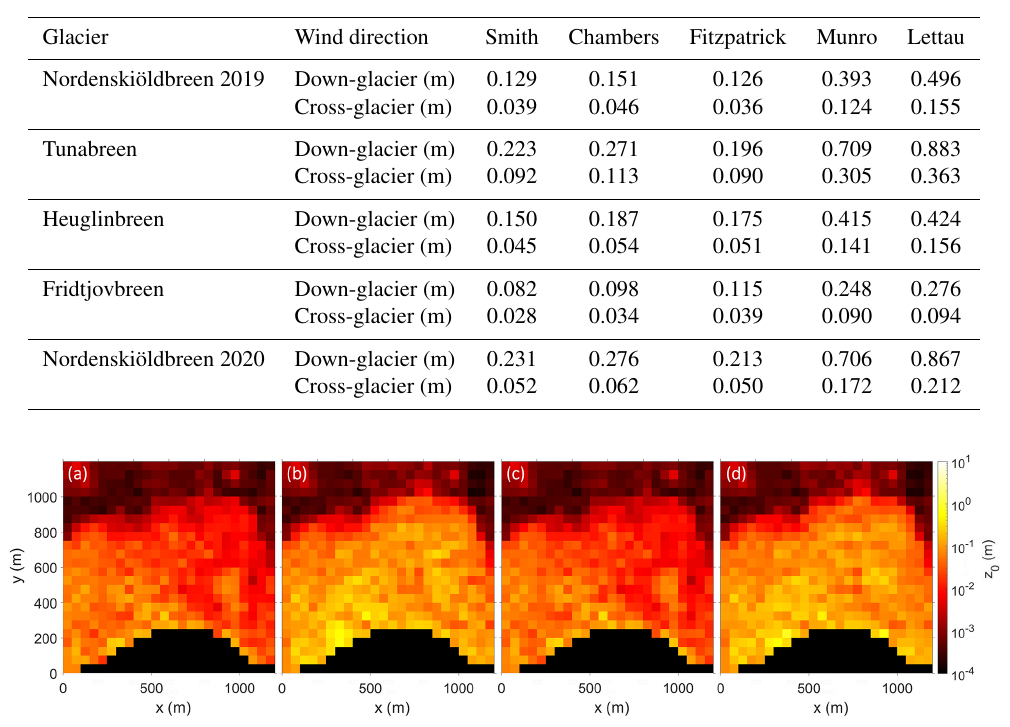
Table 4. Overview of mean z 0 values (m) for each glacier and model either for the down-glacier or cross-glacier (left-to-right) wind direction.